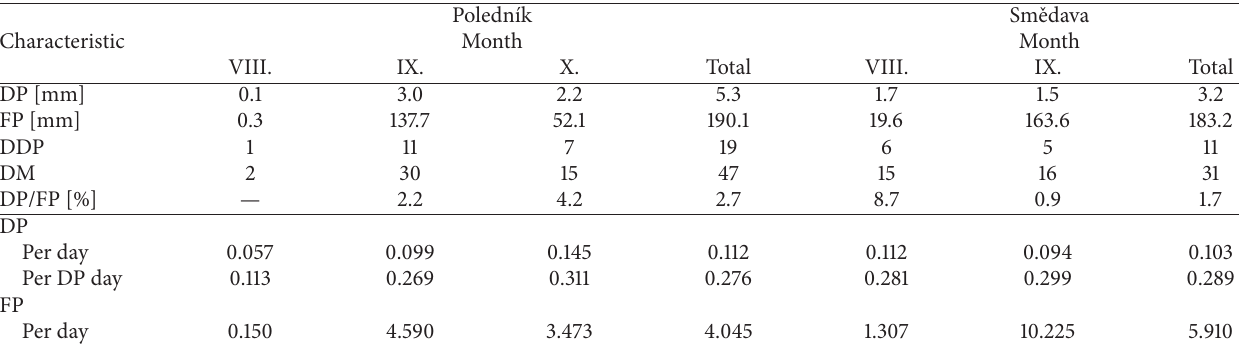
Table 2: Evaluation of precipitation amount at the Poledn´ık and Smˇedava localities (year 2013).